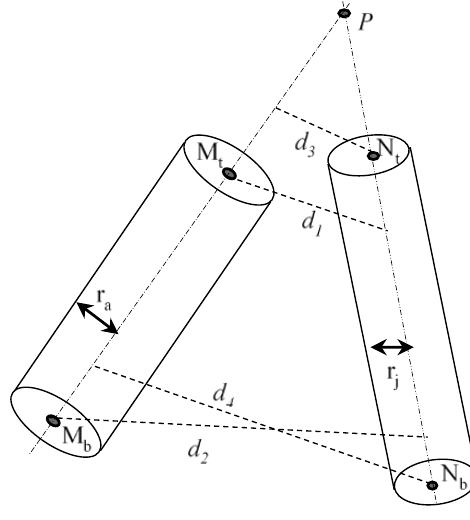
Figure 6. Collison checks between two capsules (two axes are intersecting).